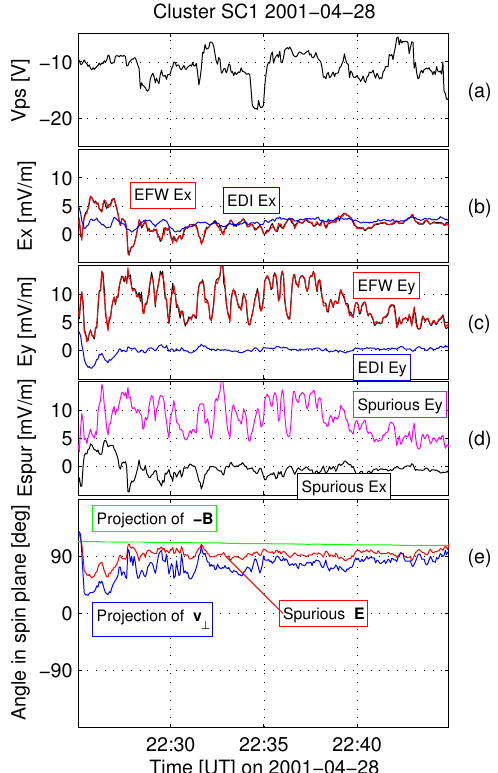
Fig. 11. Comparison of EFW and EDI data for an event with a spurious electric field in the EFW data, this time from a dawn-dusk orbit, in the same format as in Figure 9.